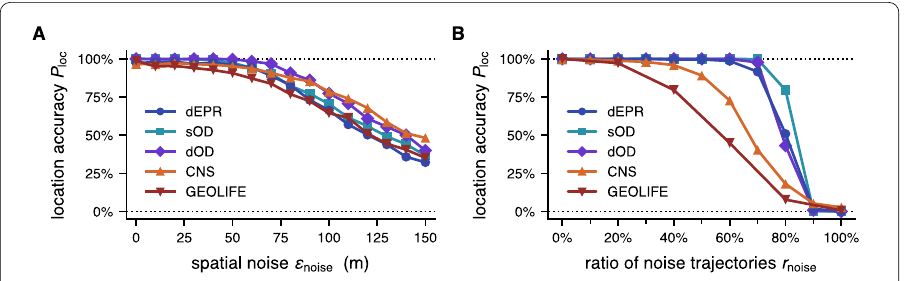
Figure 5 Robustness of the method to noise in the input data and secondary infections. A We apply Gaussian noise with standard deviation (cid:5) noise to the location data of N = 4 individuals. The accuracy decreases only after unrealistically high levels of noise are applied, compared to the mean smartphone GPS accuracy of 4.9 m [63]. B We test the robustness to individuals in the sample that were not present at the outbreak origin, for example due to secondary infections. Starting with a sample of N = 10 individuals, we replace a fraction of